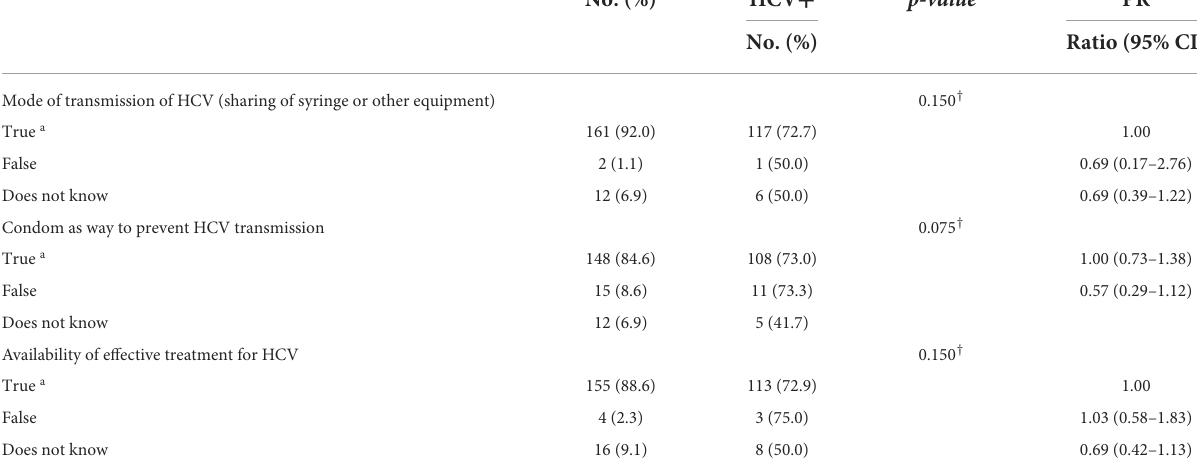
TABLE 5 Knowledge regarding hepatitis C (treatment and prevention).